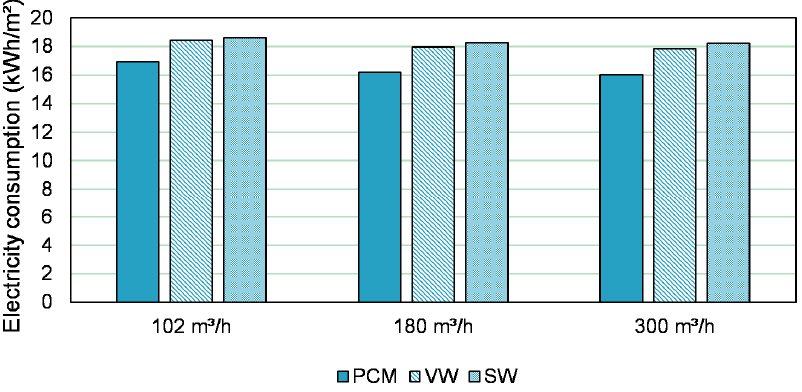
Figure 15. The summer total electricity consumption of the house (six-month period) under different ventilation flow rates.